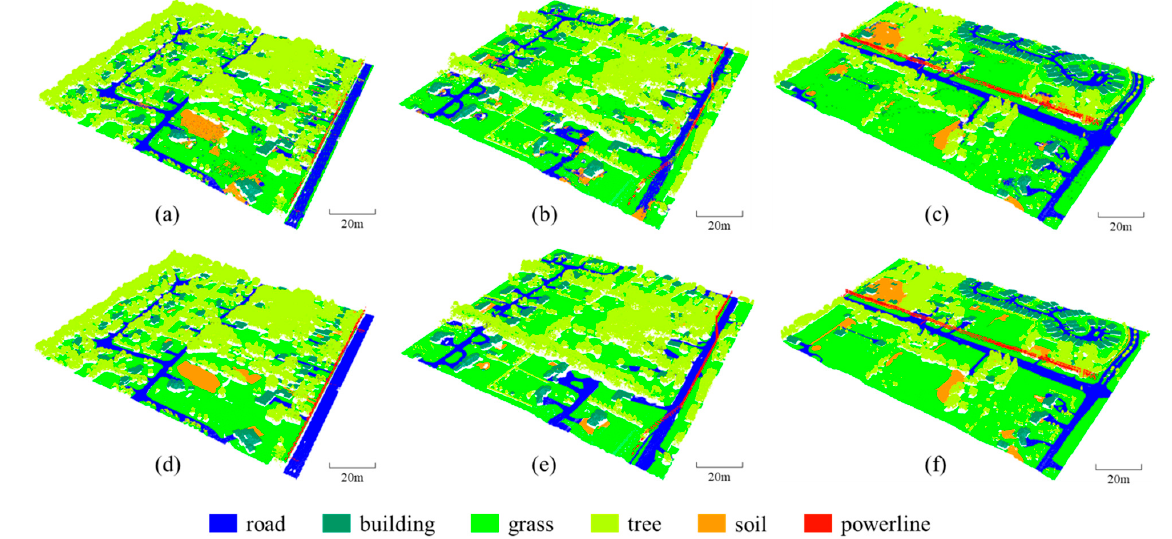
Figure 7. Comparison results of the SE-PointNet++. ( a – c ) are the point cloud classification results of the SE-PointNet++. ( d – f ) represent the ground truth of the three test areas, respectively.